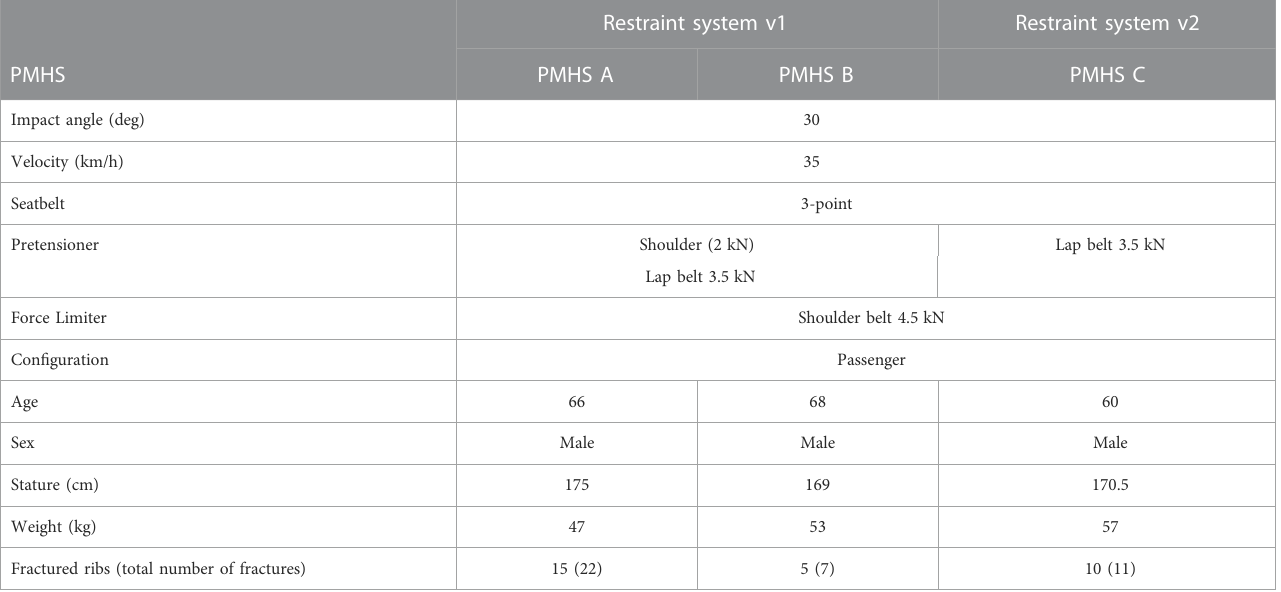
TABLE 1 Test setup and PMHS information including injury